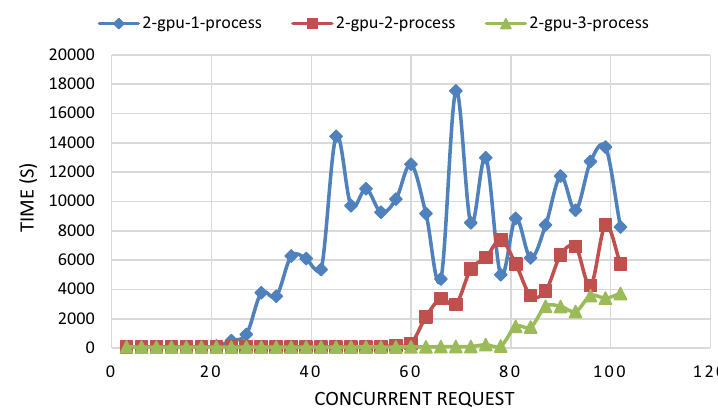
Fig. 9 Execution time (seconds) based on the concurrent request for 2